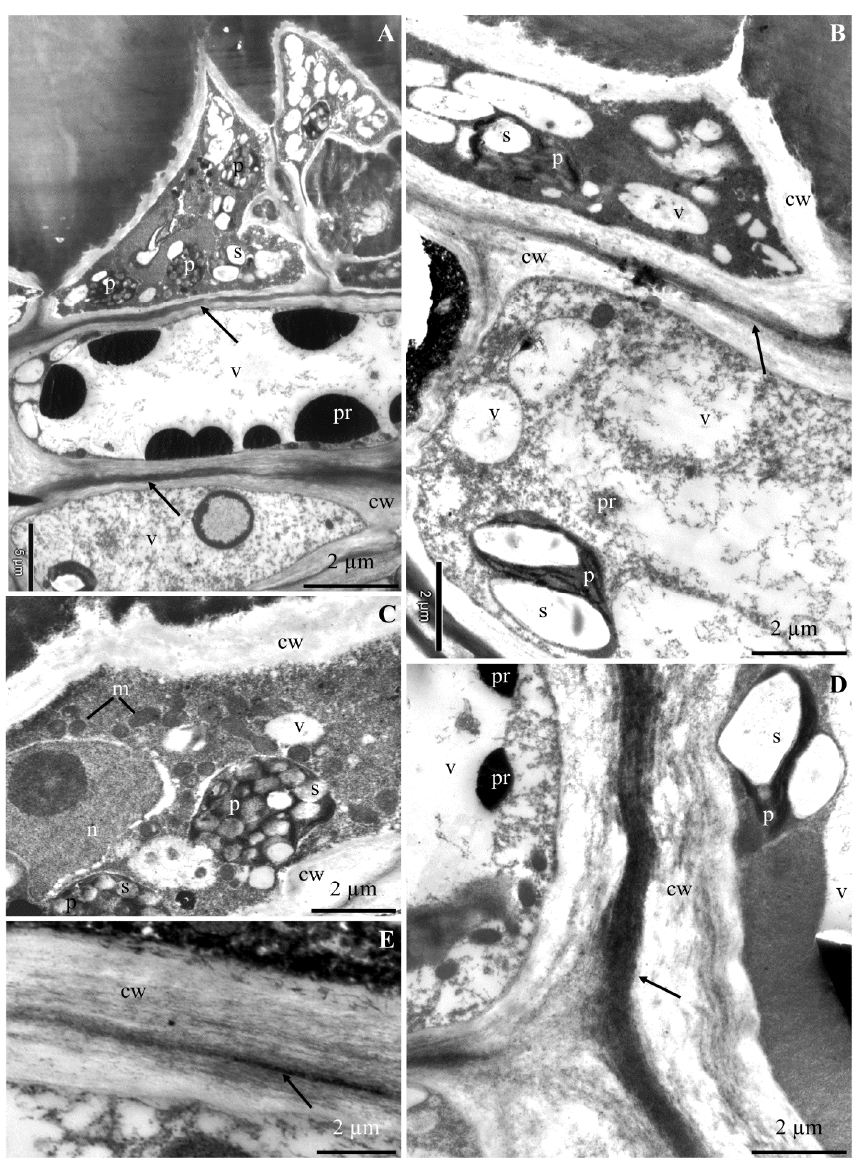
Figure 3. Fragments of the cross sections of epidermis and hypodermis cells from the apical part of ‘Szampion’ apples from the Ca(NO 3 ) 2 foliar feeding treatments. A , B : normally developed cell wall (cw) in epidermis and hypodermis cells, clearly visible middle lamella (arrow), plastids (p) with starch grains (s), vacuole (v) with precipitates (pr) adhering to the tonoplast and flocculent substance. C : epidermis cell wall (cw), numerous mitochondria (m), plastids (p) with starch grains (s), spherical cell nucleus (n) with a nucleolus, vacuole (v). D : hypodermis cell wall (cw), visible middle lamella (arrow), plastid with starch grains (s), vacuole (v), flocculent substance and precipitates (pr) in cell sap. E : hypodermis cell wall (cw), visible middle lamella (arrow).